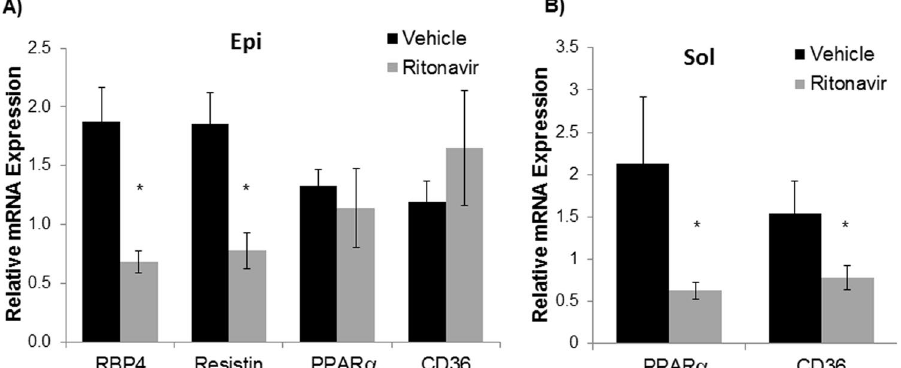
Figure 5. Effects of Chronic Ritonavir Treatment on Inflammation and Insulin Resistance-related Gene Expression by Adipose and Soleus Tissue. The relative mRNA expression of RBP4, resistin, PPAR α and CD36 in ( A ) epididymal adipose, and PPAR α and CD36 in ( B ) soleus muscle of 75 day old male TG9 mice, treated with vehicle or ritonavir since 6 weeks of age, was examined by RT-PCR as described in Methods. (n = 4–5/group). * p < 0.01 vs.